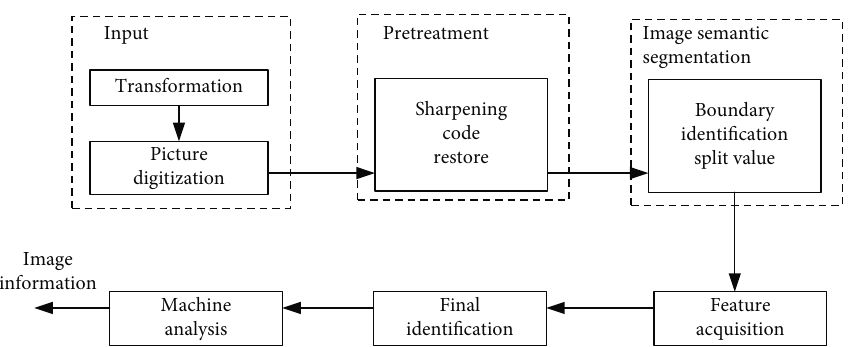
Figure 4: Image processing and semantic segmentation